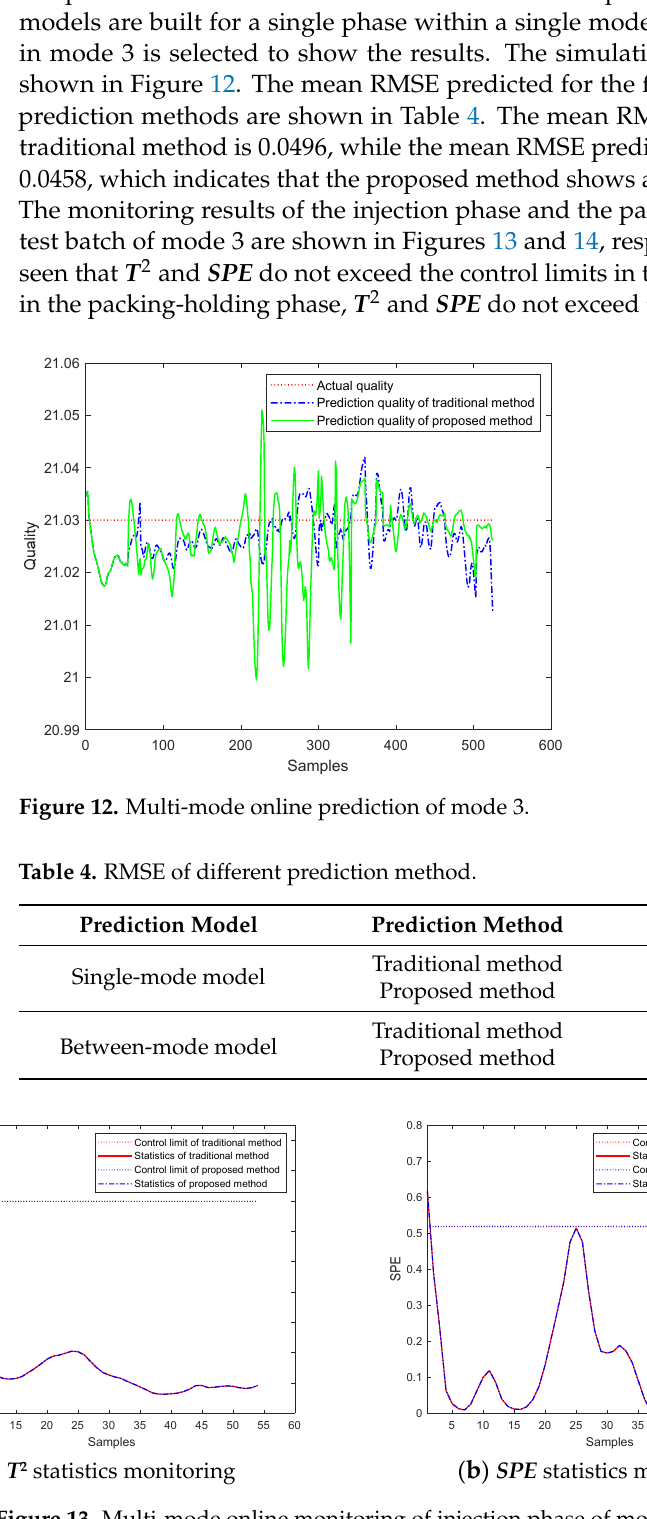
Table 4. RMSE of different prediction method.